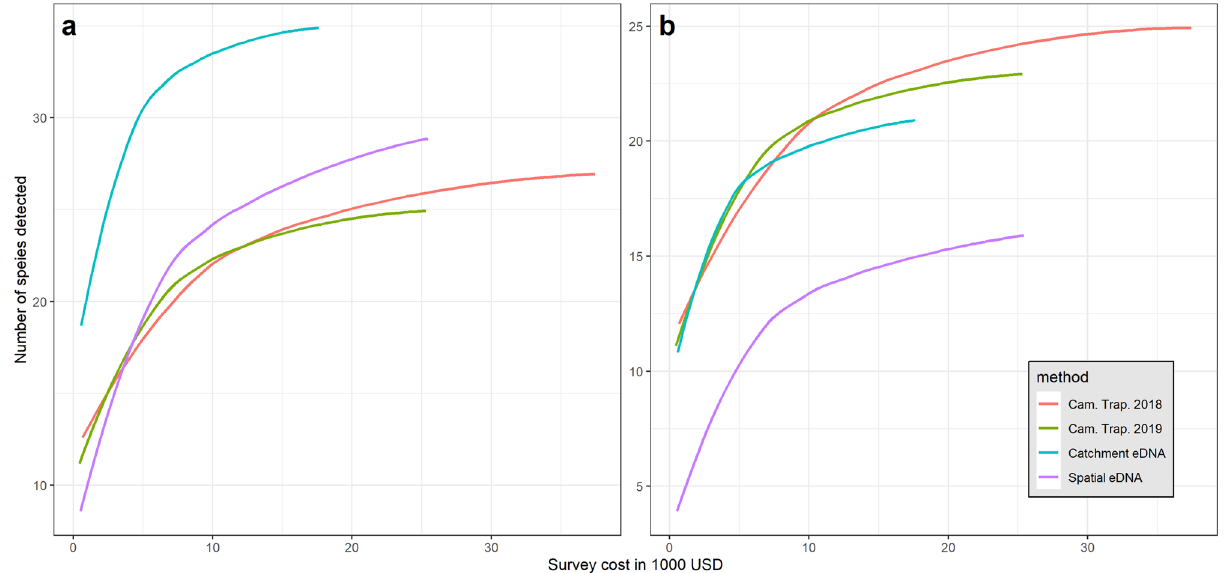
Figure 5. Comparison of cost-efficiency between survey methods to recover the total mammal diversity at the study scale. The figures show the curves of cumulative total mammals’ diversity (y-axis) per thousand USD (x-axis) invested in the survey. Colours indicate the different survey methods and years as shown in the legend. The panel ( a ) compares methods’ cost effectiveness when all the taxa detected by either method are included in the analysis, while panel ( b ) only includes species targeted by camera trapping methods (see “Methods” section). Detailed cost analyses per survey are presented in the method section (see also Table 1 and Supplementary Table